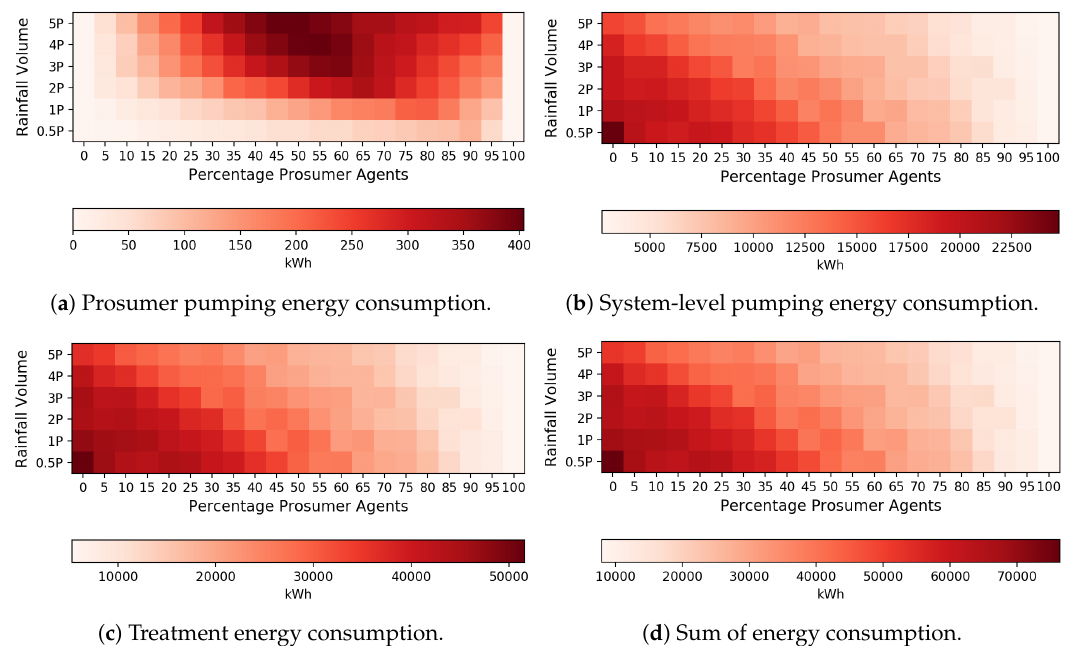
Figure 9. Energy consumption for ( a ) prosumers for pumping water at households, ( b ) system-level pumping, ( c ) treatment of water at the treatment plant, and ( d ) the sum of energy consumption for prosumers, system-level pumping, and water